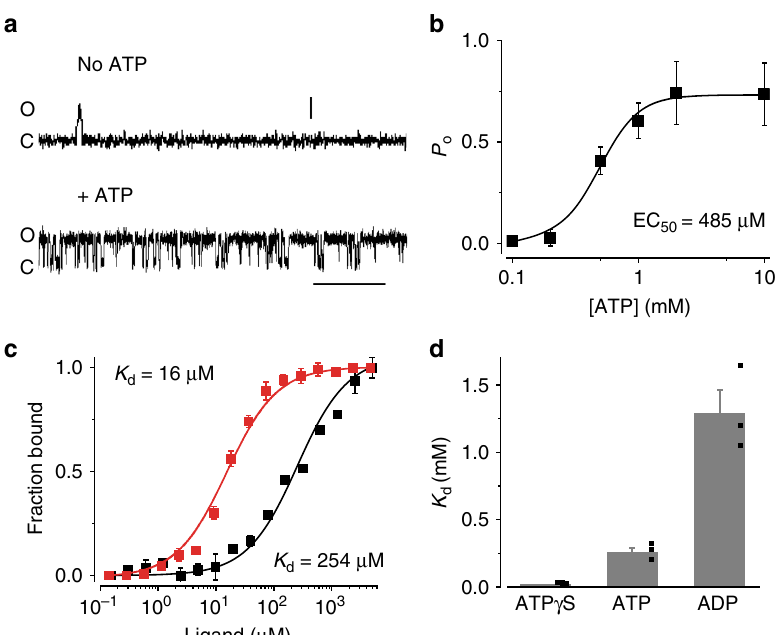
Fig. 1 The in fl uence of ATP on KpBest and the interaction between them. a Current traces of single KpBest channels recorded from planar lipid bilayers at 80 mV in the absence (top) and presence (bottom) of 2 mM ATP (Scale bar, 3.5 pA, 250 ms). b The open probability of the KpBest channel with different concentrations of ATP. n = 3 for each point. The plot was fi tted to the Hill equation. c The MST binding curves of KpBest to ATP (black) and ATP γ S (red). Protein fraction bound vs. ligand, n = 3 for each point. d Bar chart showing the binding af fi nities of KpBest to ATP analogs. n = 3 for each bar. All error bars in this fi gure represent standard error of the mean